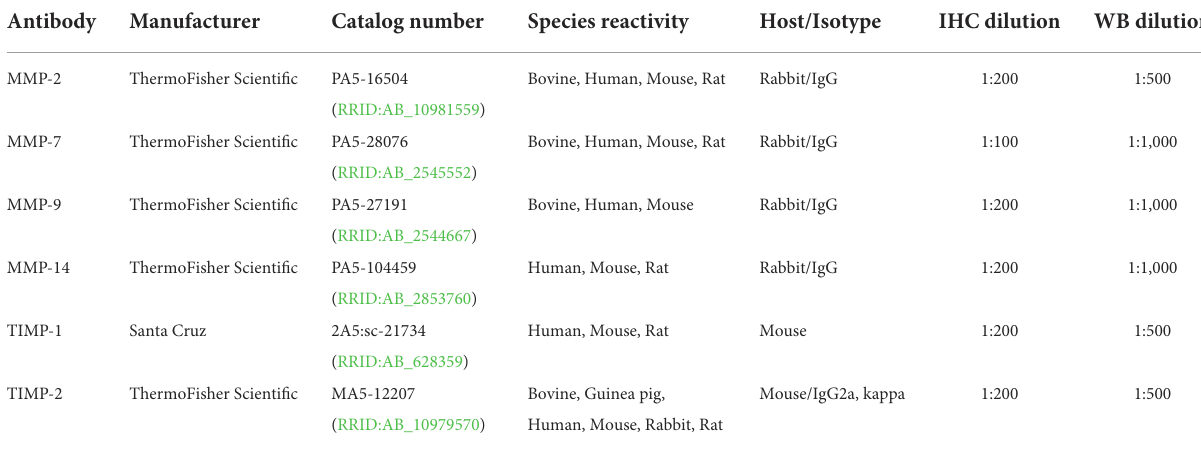
TABLE 1 Primary antibodies used for immunohistochemistry and western blotting analysis.